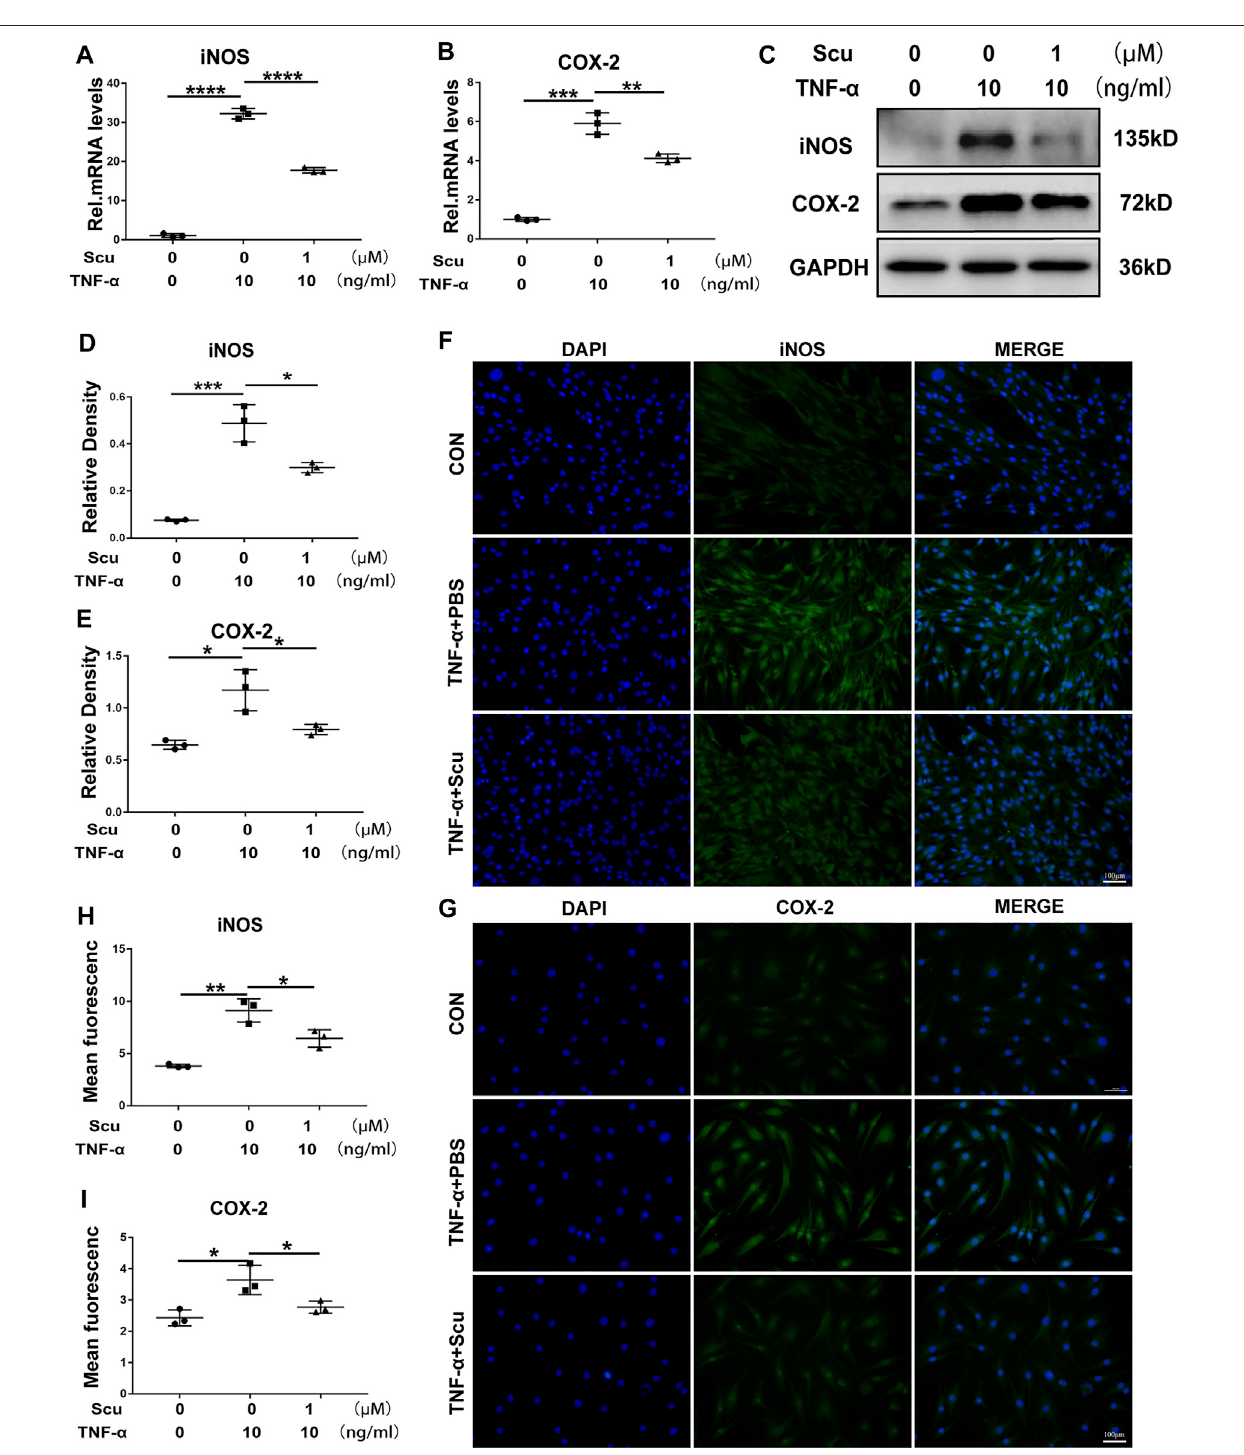
FIGURE1| ScutellarinalleviatedtheTNF- α -induced in fl ammatoryresponseinHNPCs. (A,B) HNPCsweretreatedwithorwithoutTNF- α (10 ng/ml)intheabsence or presence of scutellarin (1 μ M) for 24 h. Total RNA from each group was extracted, and real-time PCR was performed to examine the mRNA expression of iNOS and COX-2. (C – E) HNPCs were treated with PBS, TNF- α (10 ng/ml), TNF- α (10 ng/ml) +scutellarin (1 μ M) for 48 h. The protein extractions of each group were detected by Western blotting with anti-iNOS and antiCOX-2 antibodies. (F – I) HNPCs were cultured as indicated for 48 h. Immuno fl uorescence cell staining was performed to detect the expression of iNOS and COX-2 (scale bar: 100 μ m). Each experiment was performed three times independently. (* p < 0.05, ** p < 0.01, *** p < 0.001, **** p < 0.0001).